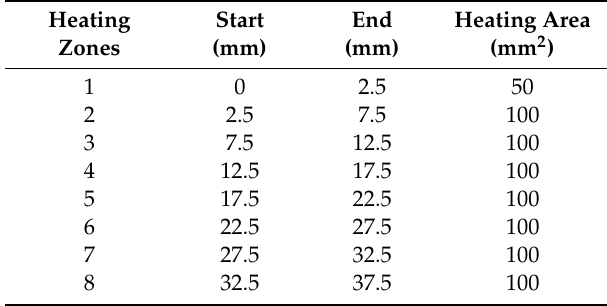
Figure 6. Configuration of the heating films on the test model. Table 1. Heating zones length streamwise.